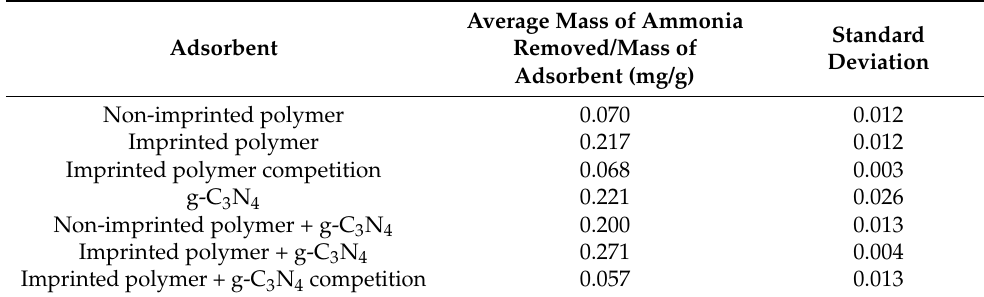
Table 3. Ammonia removal in adsorption columns by different adsorbents with 8 mg/L ammonia influent